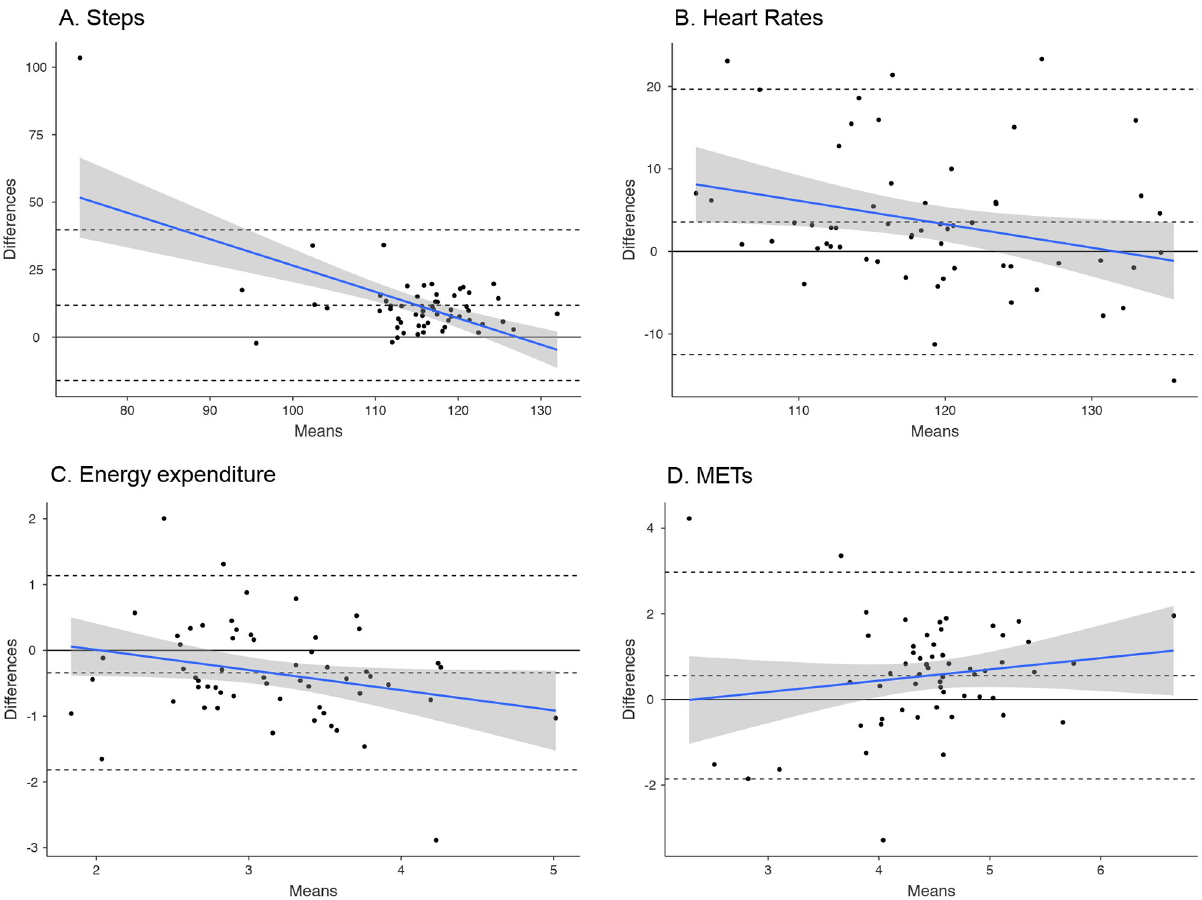
Fig 1. Bland-Altman plots for average steps (A), heart rate (B), energy expenditure (kcal) (C) and METs (D) per minute. The central dotted line represents the Bland-Altman biases; the thin dotted lines represent the Bland-Altman agreement limits.